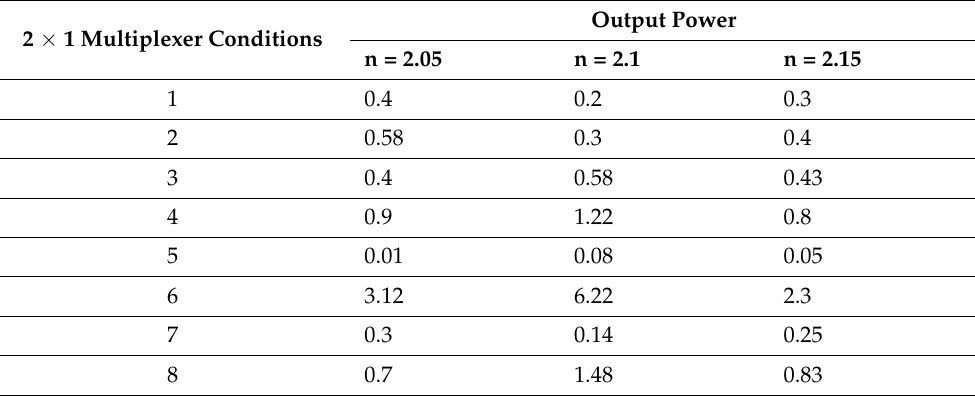
Table 3. Output power analysis of 2 × 1 multiplexer with various refractive indices (n). 2 × 1 Multiplexer